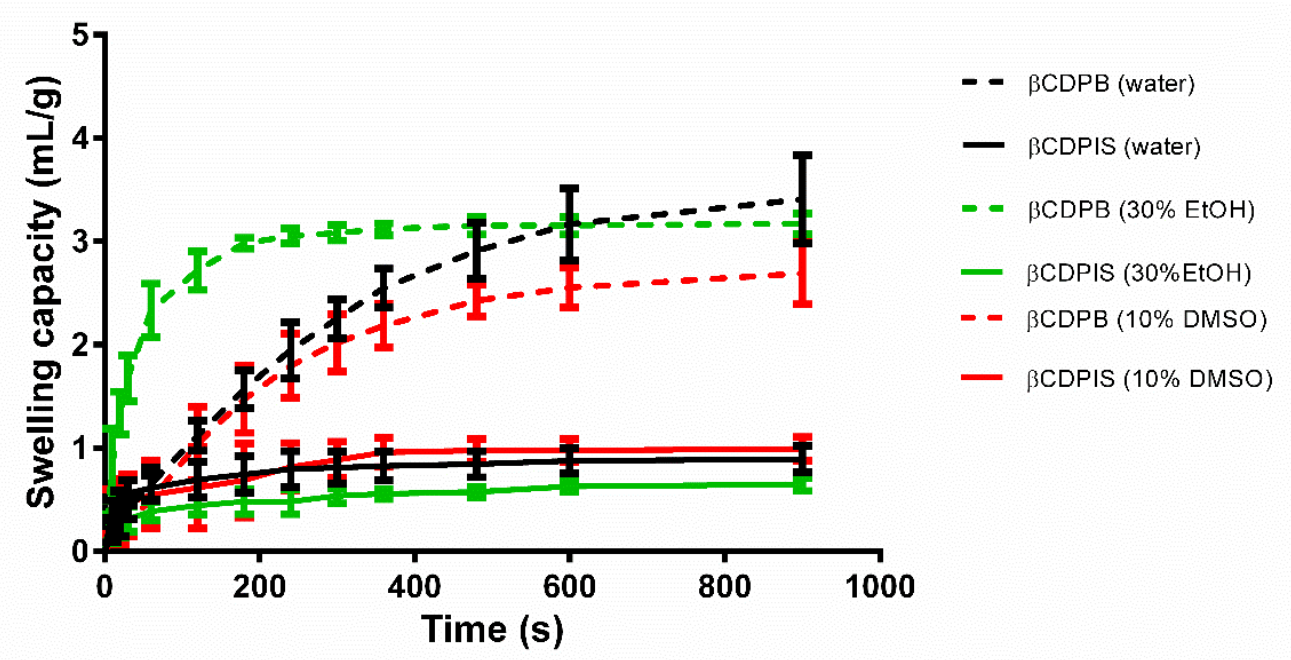
Figure 4. Swelling capacity of carriers in water, 30% Ethyl alcohol, and 10% DMSO solution (data are presented as means ± SD, n = 3).